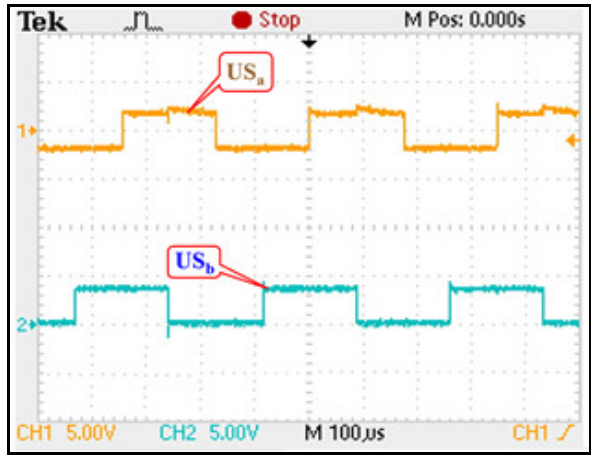
Figure 21. Measured up–arm voltages in the U–phase and V–phase (US a and US b , respectively).